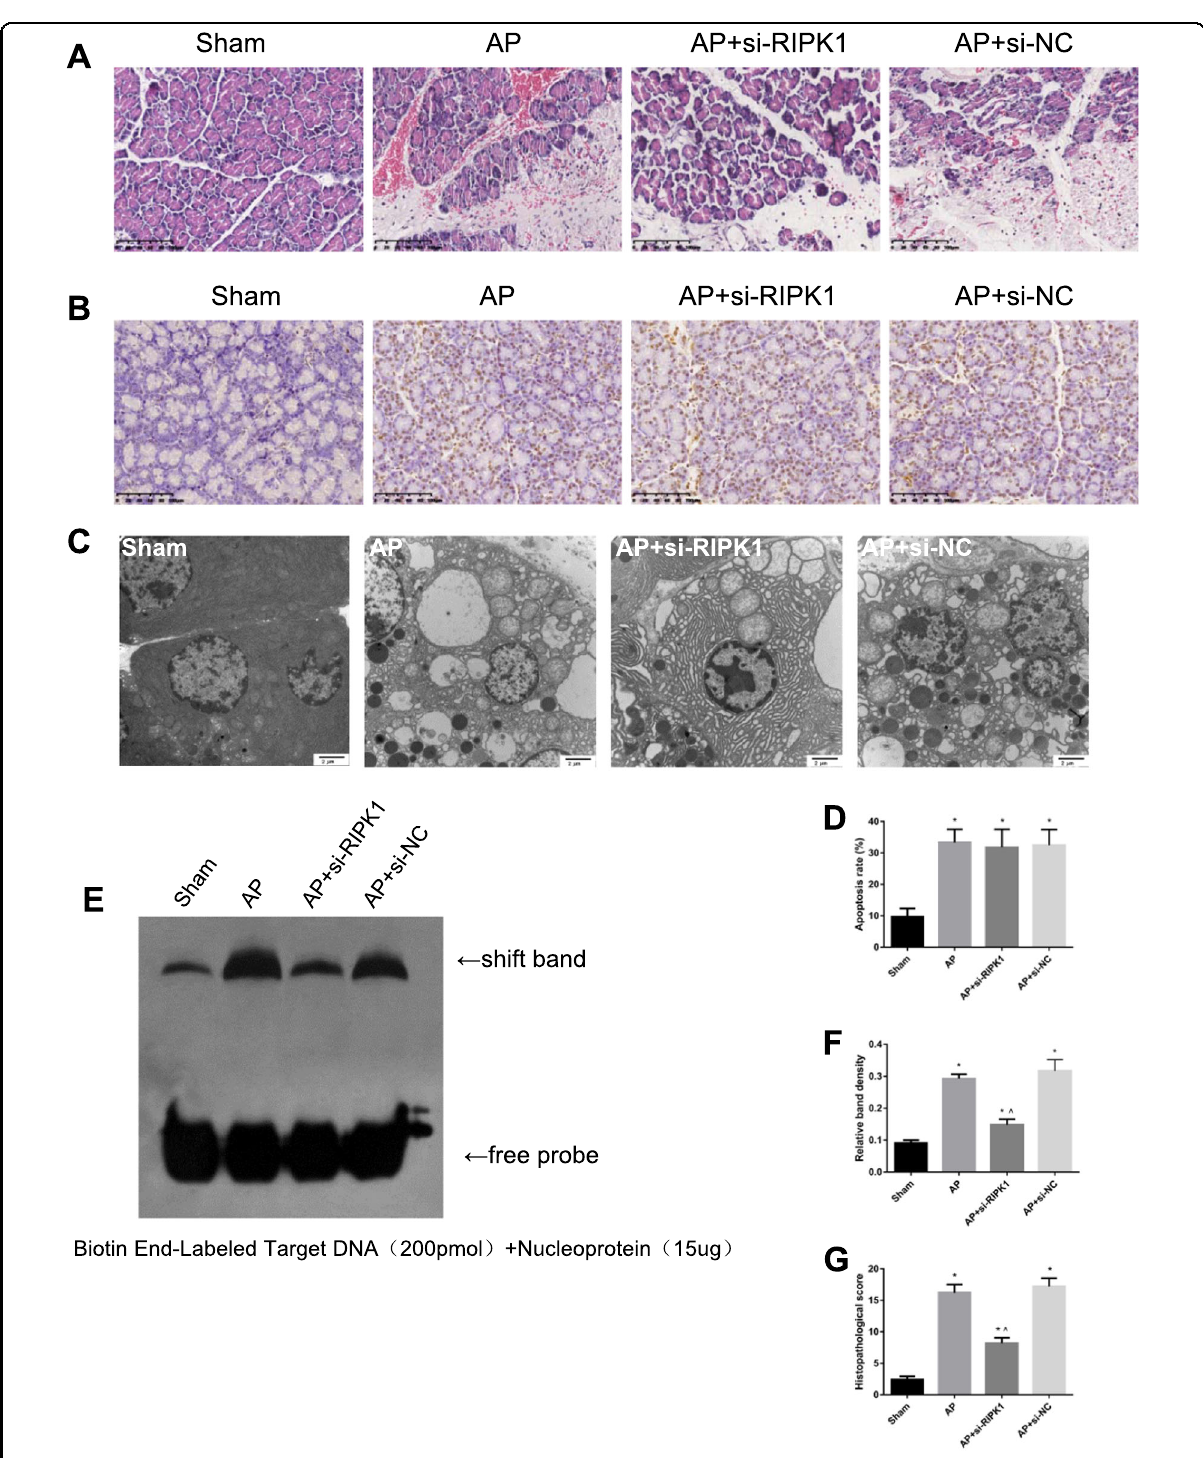
Fig. 3 Inhibition of RIPK1 attenuated AP-related injury in rats. a Representative images (4×) of hematoxylin and eosin-stained pancreatic tissues harvested from rats subjected to sham operation, AP, AP + si-RIPK1 or AP + si-NC for 24 h after AP induction. b TUNEL analysis of apoptotic cells and d the apoptosis index in pancreatic tissues harvested from the rats described in Fig. 3a. c Representative TEM images of pancreatic tissues from the rats described in Fig. 3a; bar: 2 μ m. e EMSA analysis and f quantitation of NF- κ B DNA-binding activity in pancreatic tissues harvested from the rats described in Fig. 3a. g Histopathological scoring was performed to evaluate pancreatic injury in the rats described above. The data are the means ± S. Ds. ( n = 3). * P < 0.05 versus sham, ^ P < 0.05 versus